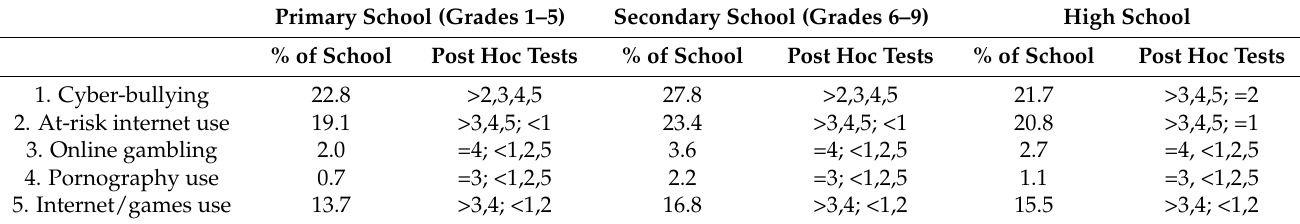
Table 3. Percentage of schools that conducted prevention interventions of screen-related risk behaviors during the fall 2020 wave of COVID-19-related distant schooling period in primary (n = 1068), secondary (n = 934), and high schools (n = 451). Response scale was 1 to 5.